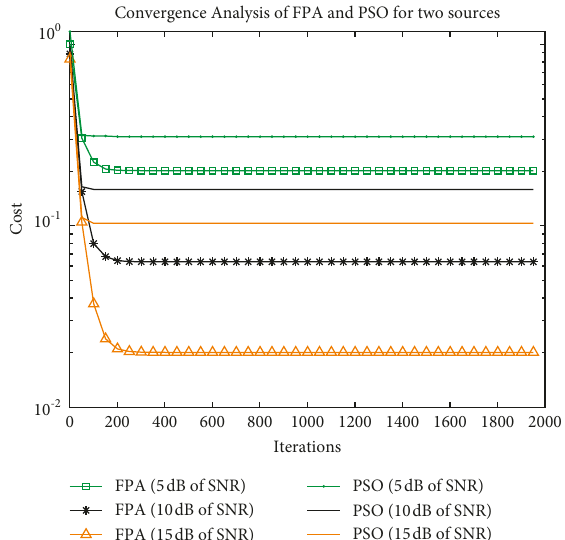
4: Convergence analysis of FPA for three